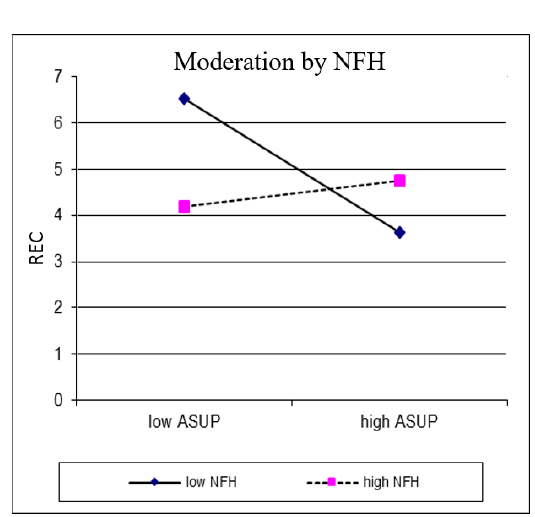
Figure 3. Moderation Test.